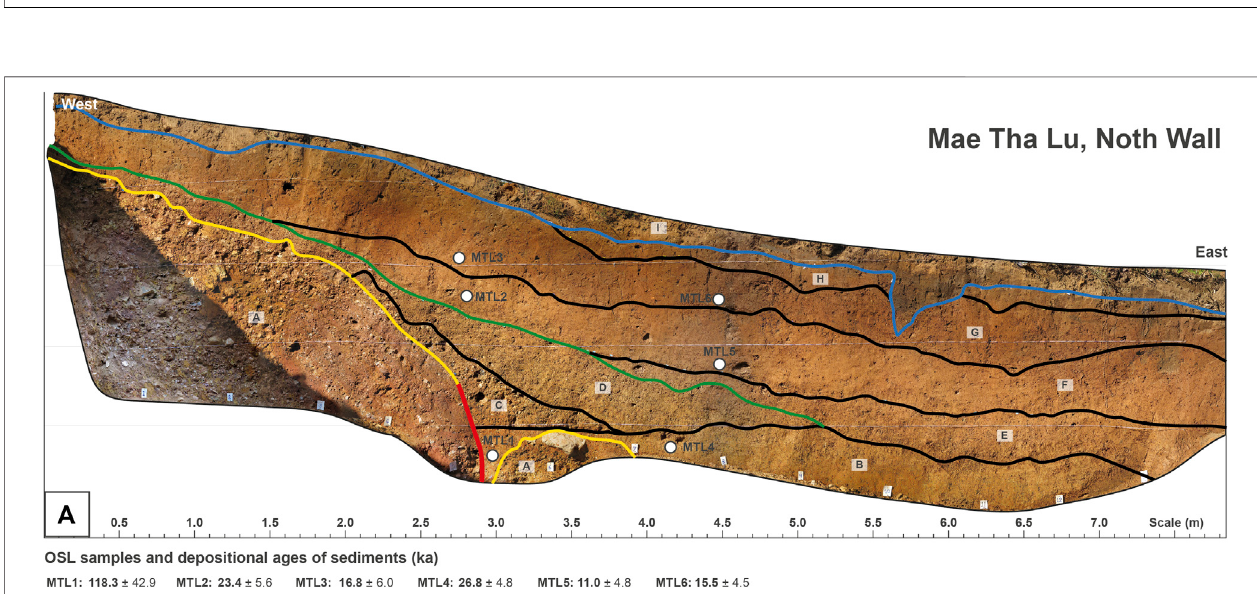
FIGURE 8 | Paleoearthquake trench section and wall log section on the north wall at Mae Tha Lu trench showing sediment stratigraphy, fault orientation, sample locations for dating, and OSL ages (in ka) of sediment layers. The trench location is shown in Figure 5C .